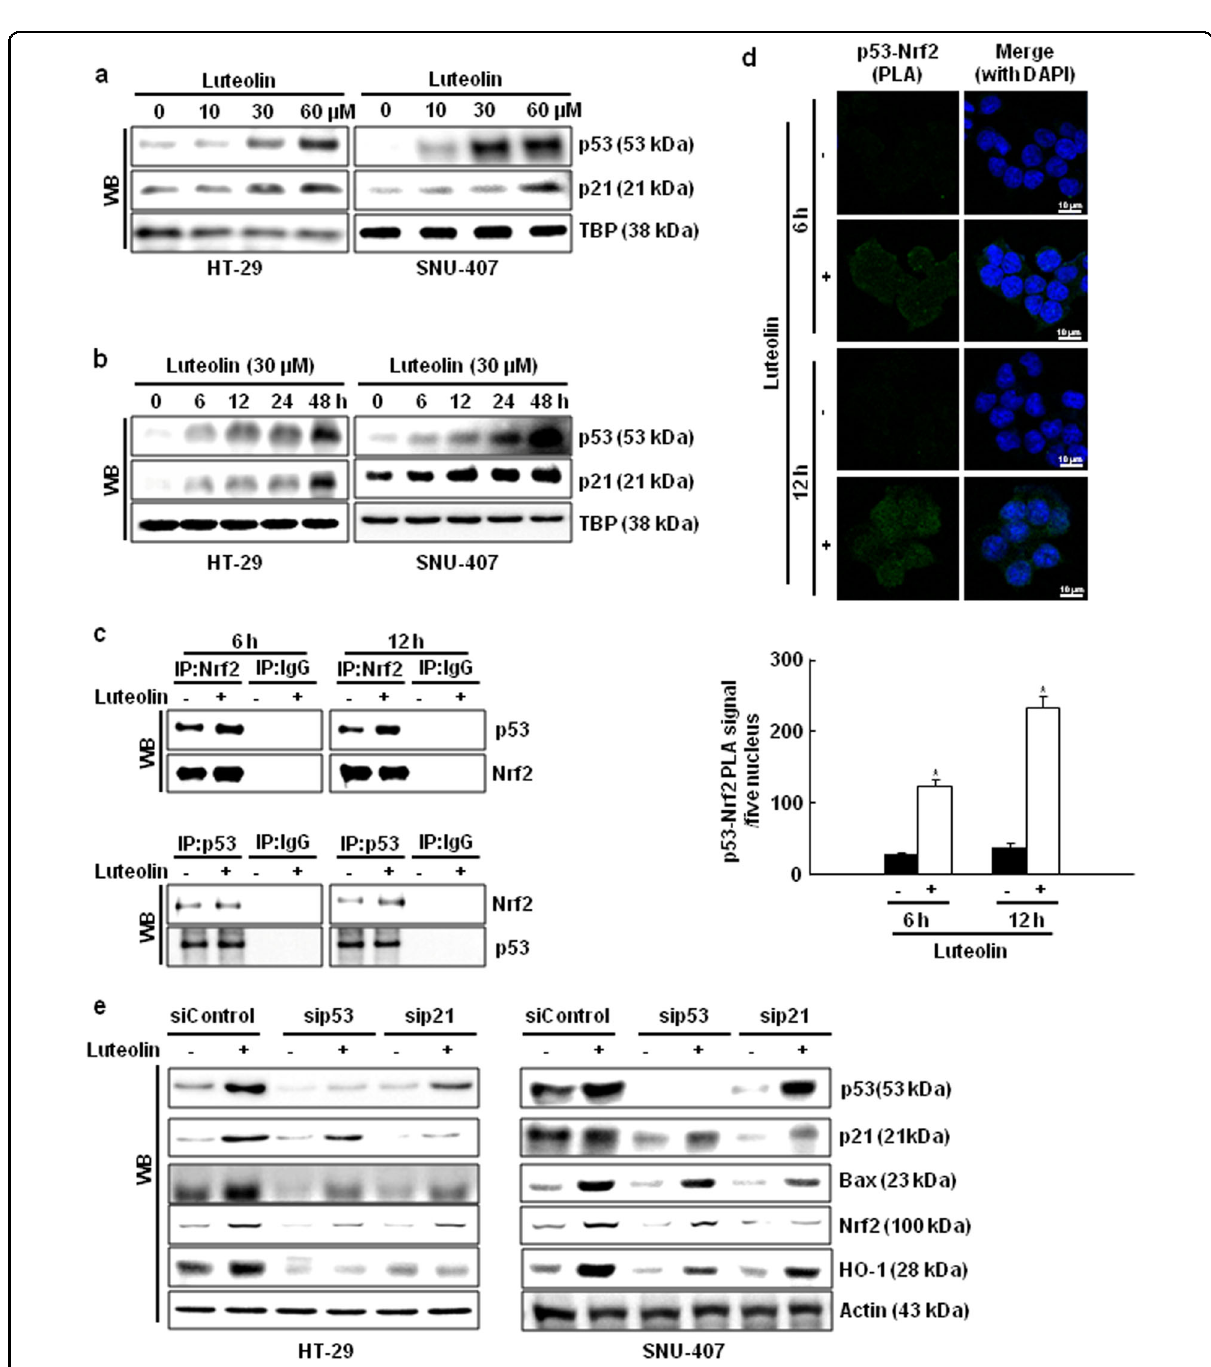
Fig. 6 Luteolin increases the interaction between Nrf2 and p53. Cells were incubated with a various concentrations of luteolin for 48 h or b 30 µM luteolin for various durations. Cell lysates were electrophoresed, and p53 and p21 proteins were detected using speci fi c antibodies. Interaction between p53 and Nrf2 was examined using c IP and western blotting with anti-p53 and anti-Nrf2 antibodies and d PLA. Each green spot represents a single interaction between p53 and Nrf2. DNA was stained using DAPI; * p < 0.05 compared with control cells. e Cells were transfected with p53 or p21-targeting siRNA for 24 h. Bax, Bcl-2, Nrf2, and HO-1 protein expression was determined using western